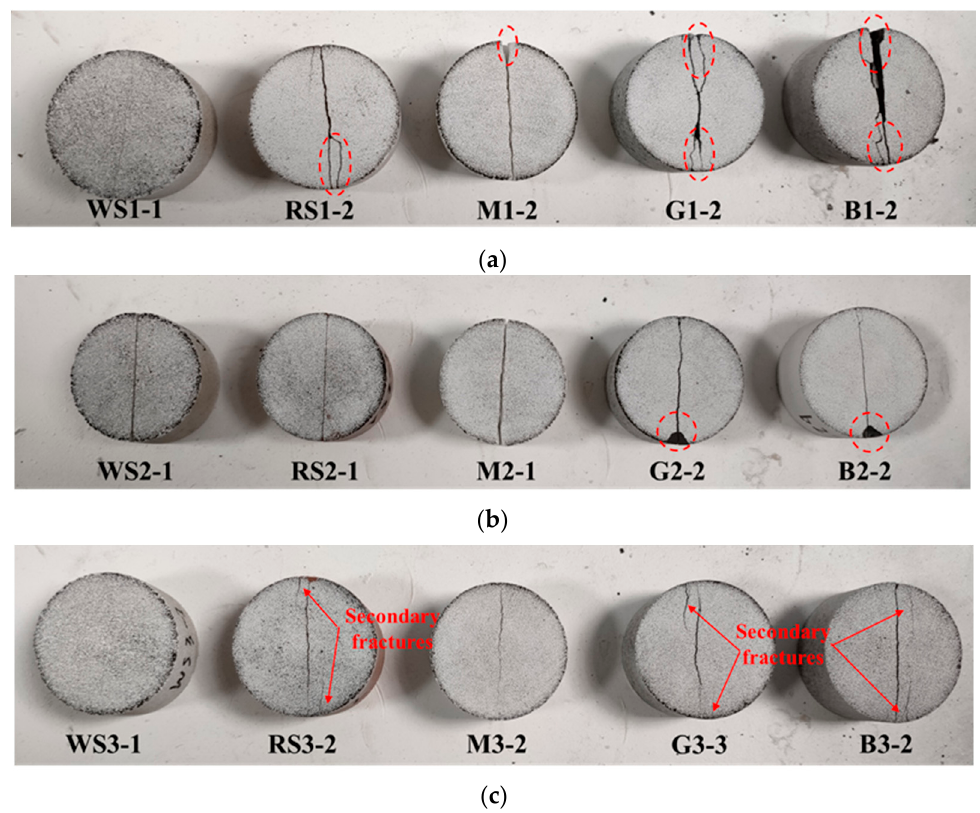
Figure 10. The failure patterns of representative specimens tested by ( a ) Type I, ( b ) Type II and ( c ) Type III loading configurations.